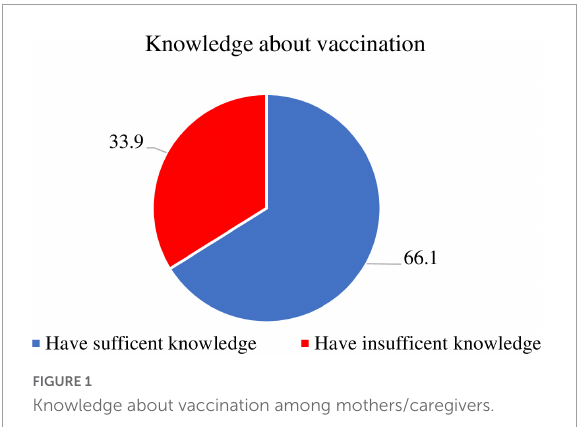
Libanos Health office. The permission letter was given to Kebeles. Informed written consent was obtained from each study participant before the interview. The confidentiality was